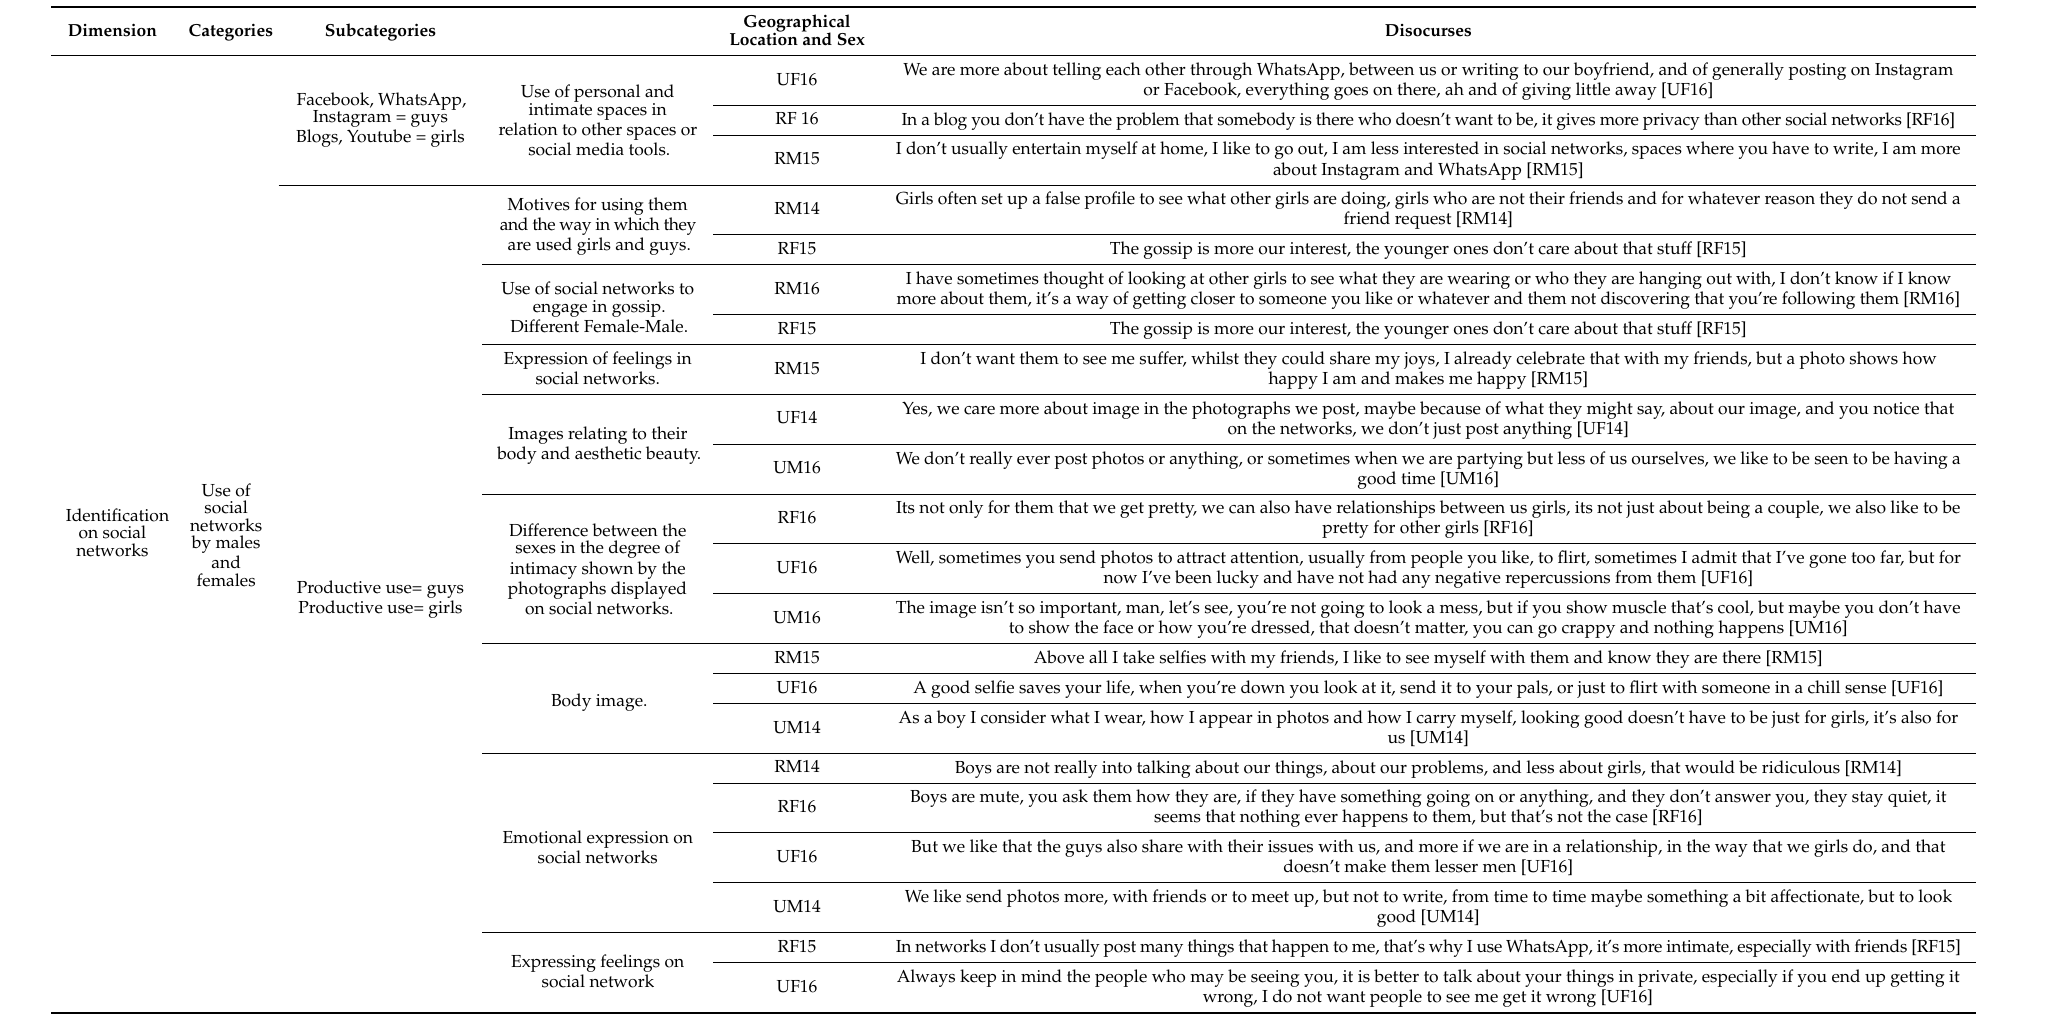
Table 13. Most significant findings of the qualitative